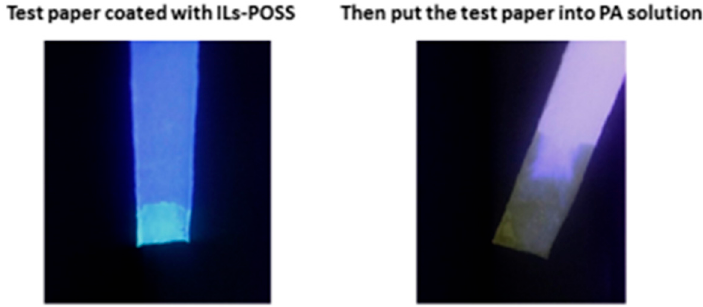
Figure 6. Photographs of test paper coated with IL-POSSs before and after being immersed into the aqueous solution of picric acid.